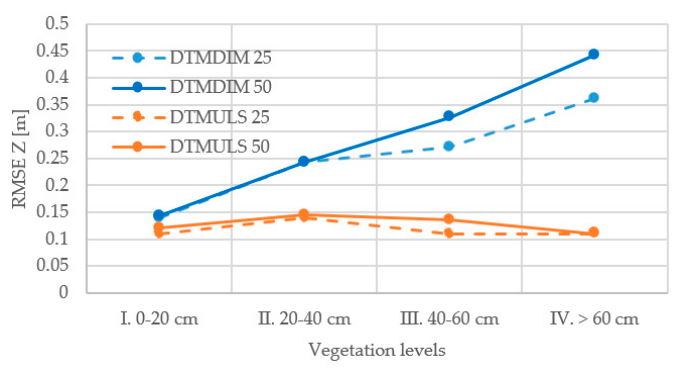
Figure 9. Vertical accuracy assessment of DTM DIM and DTM ULS based on reference geodetic field measurements.